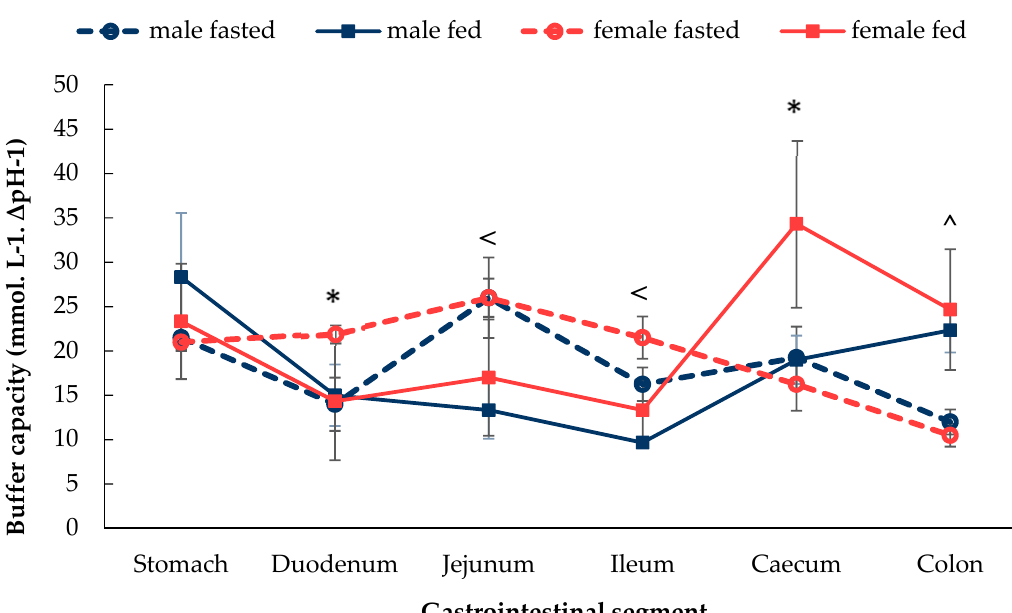
Figure 2. Bu ff er capacity ( ∆ pH = 1.0) of pooled fluids of sections of the GI tract in male and female in the fasted state and fed state rats. (Mean ± SD, n = 6). The values are the mean of several pooled fluids measurements. The following symbols (i) < denotes a statistical significance ( p < 0.05) between fasted and fed state in male rats, (ii) ˆ denotes a statistical significance ( p < 0.05) between fasted and fed state in both male and female rats and (iii) * denotes a statistical significance ( p < 0.05) between males and females.